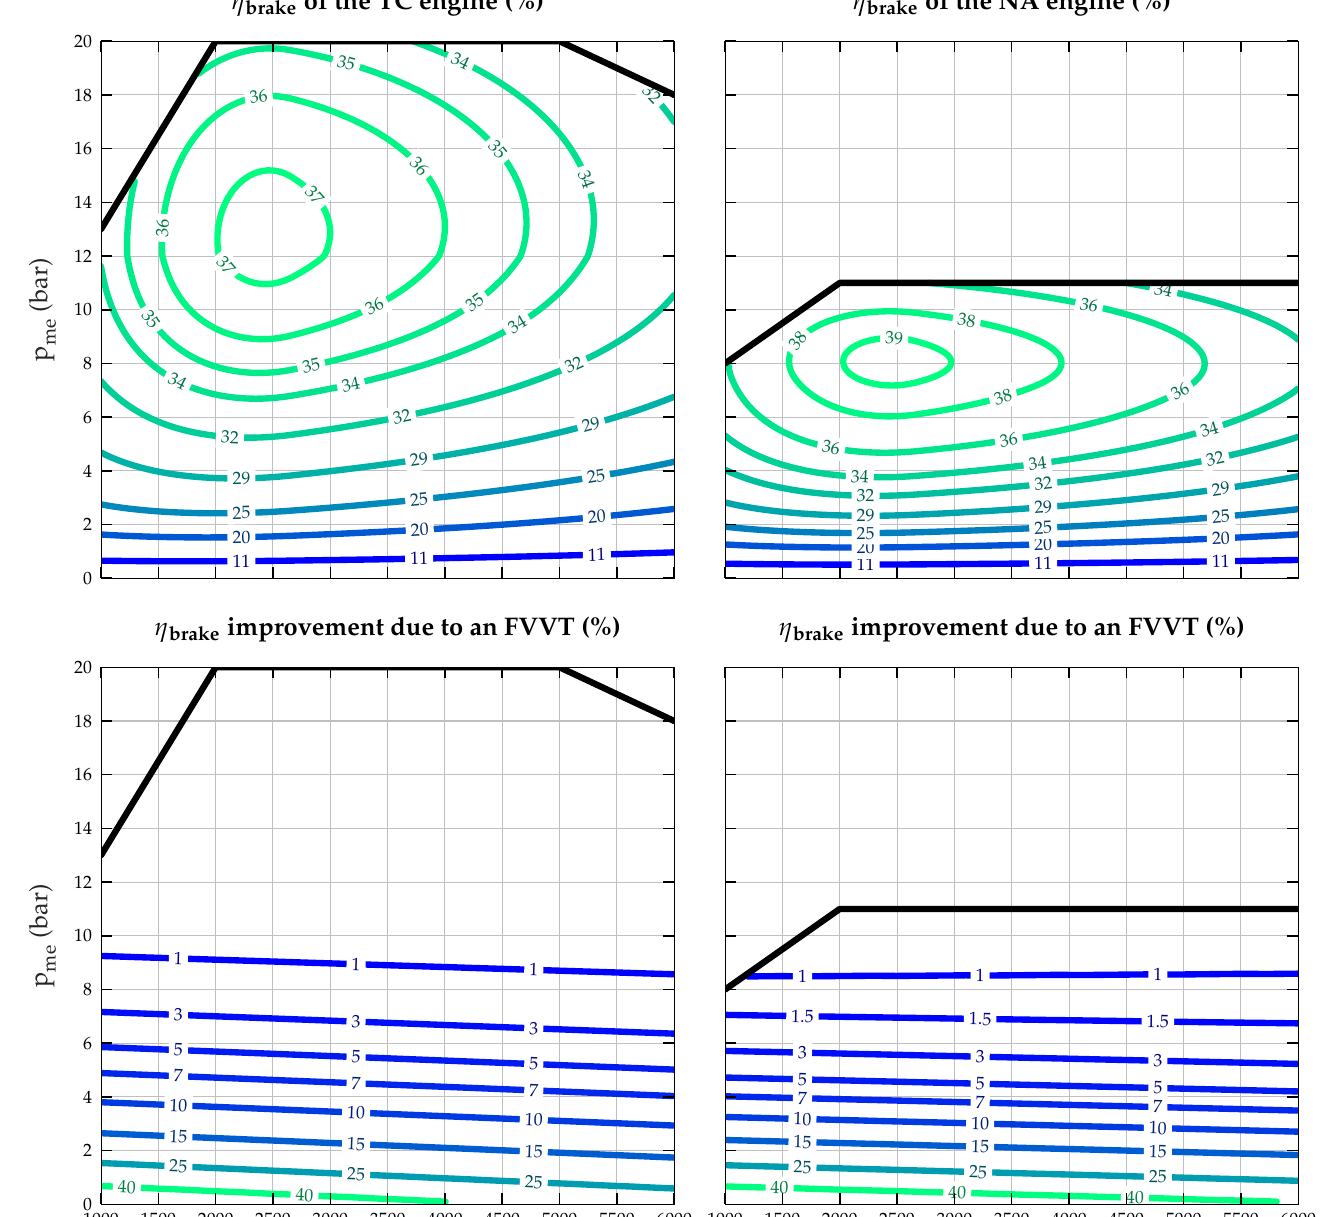
Figure 4. Brake efficiency maps fitted to the data obtained from measurements. The maps on the left-hand side stem from a TC engine while the maps on the right-hand side stem from an NA engine. The upper plots show the brake efficiency of camshaft-driven engines while the lower maps show the improvement in efficiency for the same engines but with an FVVT instead.